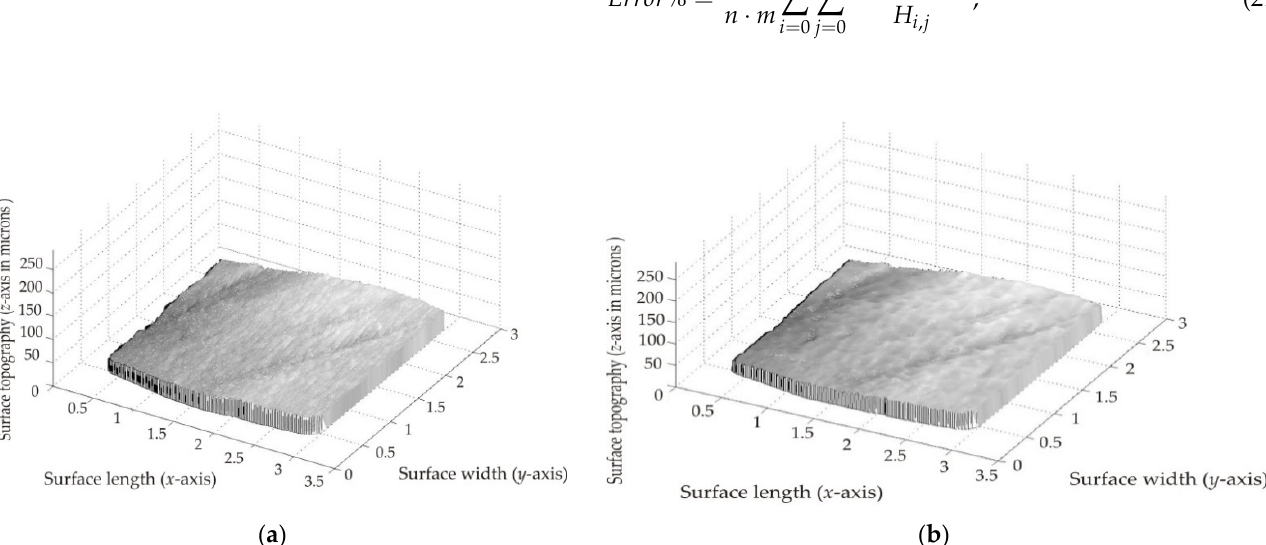
Figure 6. ( a ) Micro-scale topography recovered via micro laser line scanning. ( b ) Object surface computed by the free-form surface model generated via Equation (1).